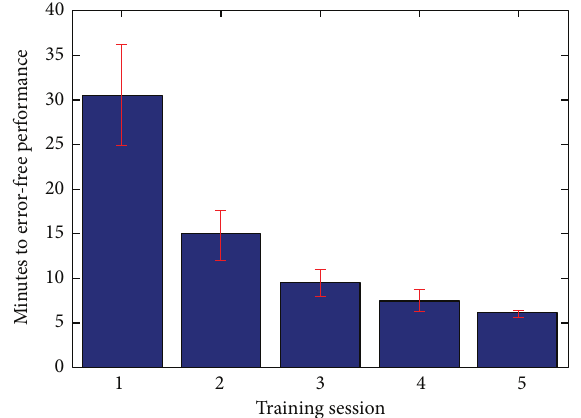
Figure 1: Mean amount of time to completion of training by day. Error bars (red) represent the standard error of the